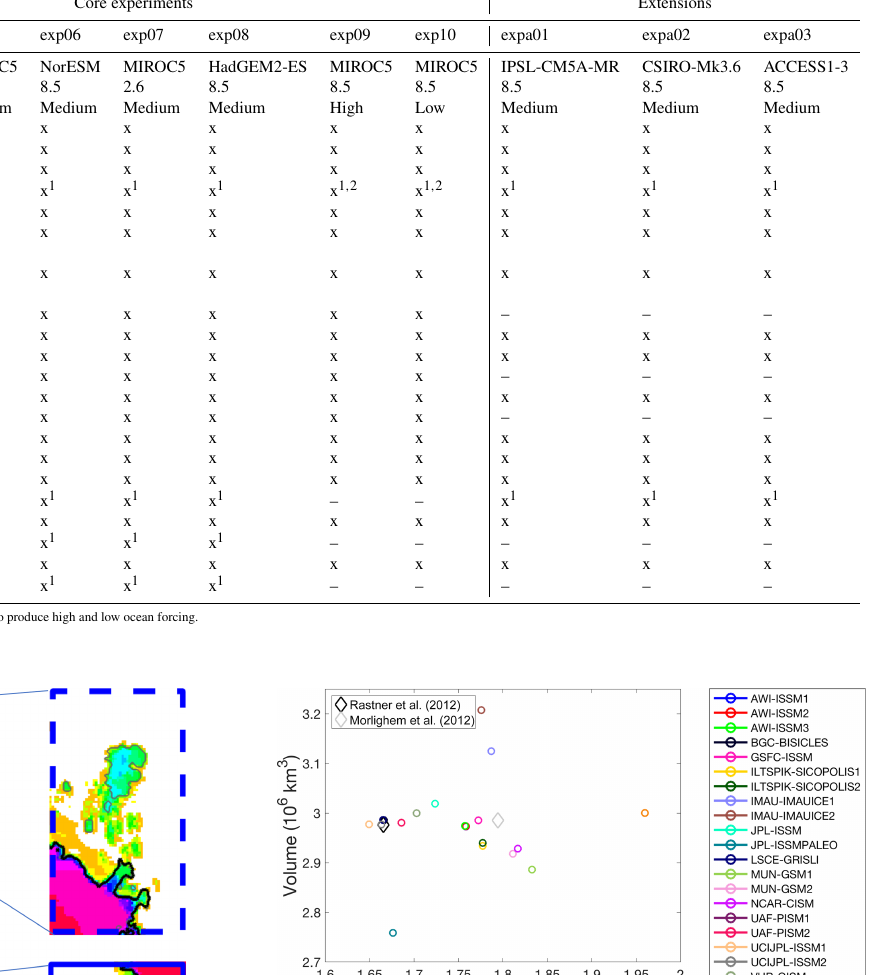
Table 3. Experiment overview. List of experiments that have been performed by the participating groups. Core experiments Extensions